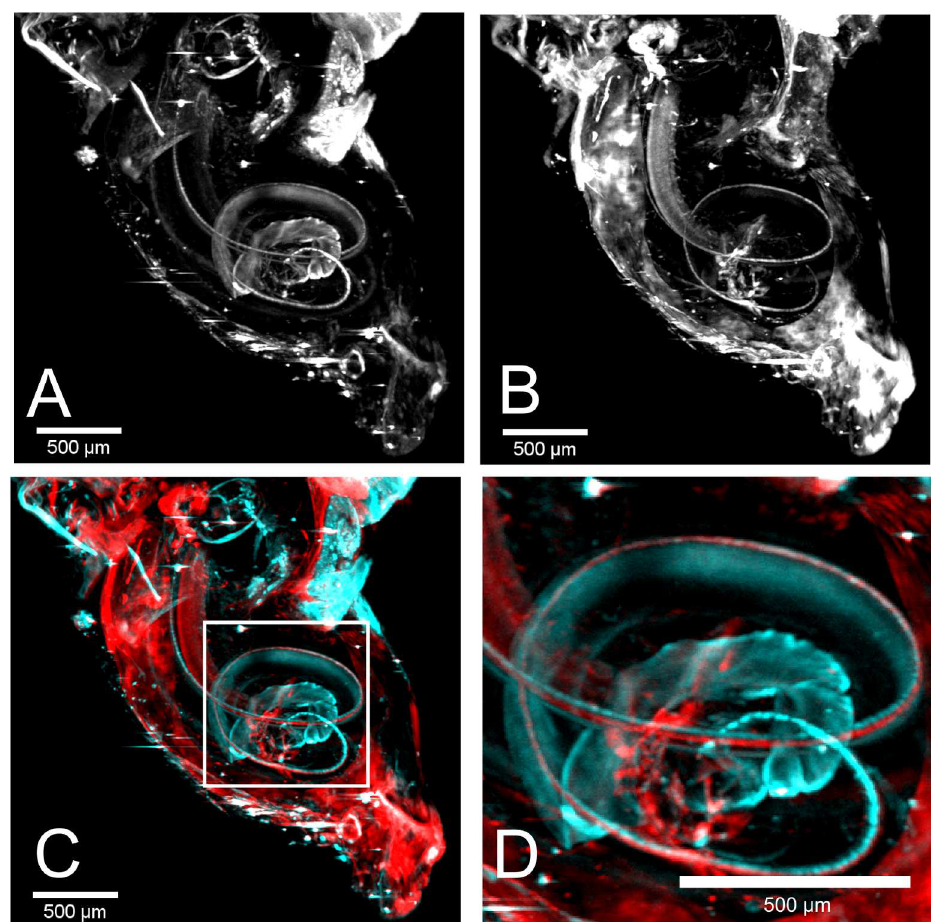
Fig 4. Double labeling of cochlea 3 with a combination of two antibodies. (A) The MIP of the neurofilament excited at 520 nm is shown. The helicalshape is visibleas for sample 1. (B) The labeledinner hair cells also appearin a helicalshapein the MIP excited at 635 nm. (C) An overlayof neurofilament (cyan) and hair cells (red) is shown. (D) Higher magnification of the highlightedregionin C. Due to the overlay the arrangement of neurofilament and hair cells